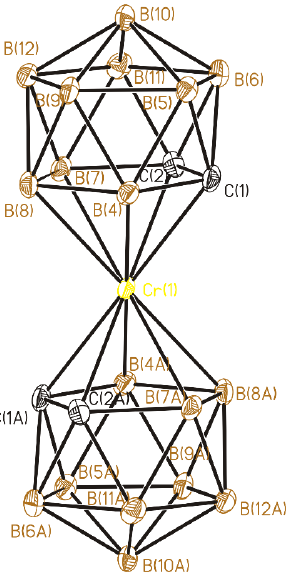
Figure 6. Anion in ( 3 ). Thermal ellipsoids are given at 30% probability level.